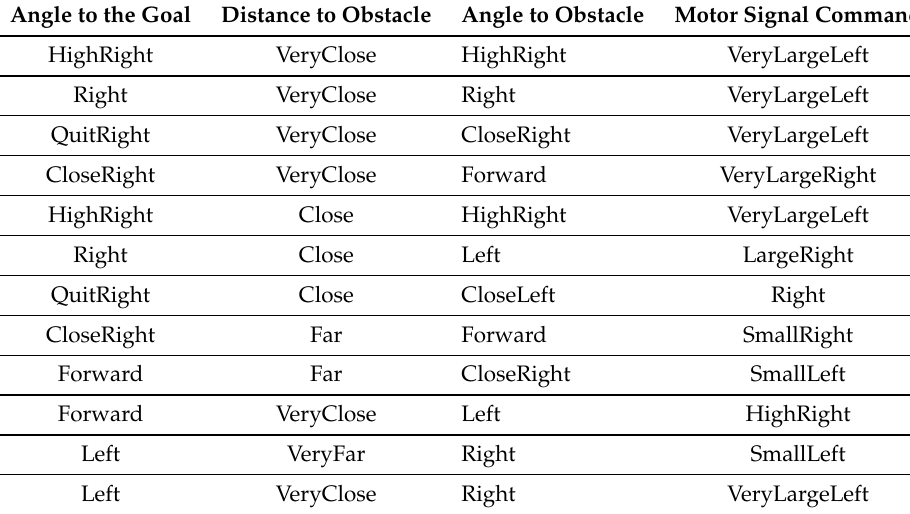
Table 2. Obstacle-Avoidance Fuzzy Rules